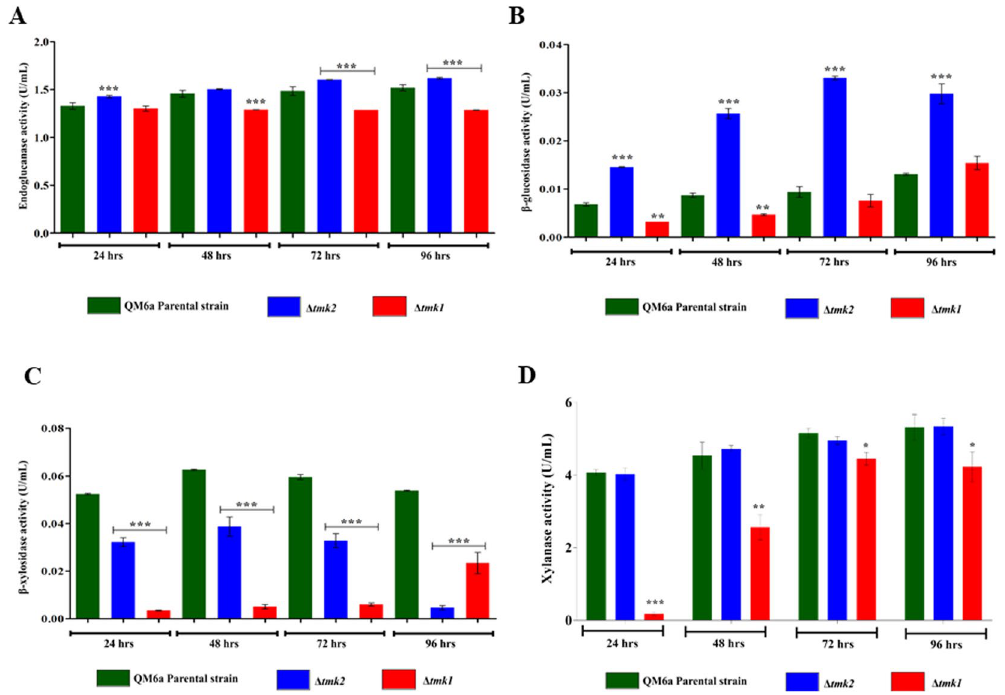
Figure 5. Holocellulolytic activities of QM6a, Δ tmk2 , and Δ tmk1 grown in sugarcane bagasse. ( A ) Endoglucanase activity (CMCase), ( B ) β -glucosidase, ( C ) β -xylosidase and ( D ) Xylanase activities from culture supernatant of T. reesei , QM6a parental strain, Δ tmk2 , and Δ tmk1 grown in the presence of sugarcane bagasse for the indicated times. *** Significantly different from the QM6a parental strain (P < 0.001) and * Significantly different from the QM6a parental strain (P <